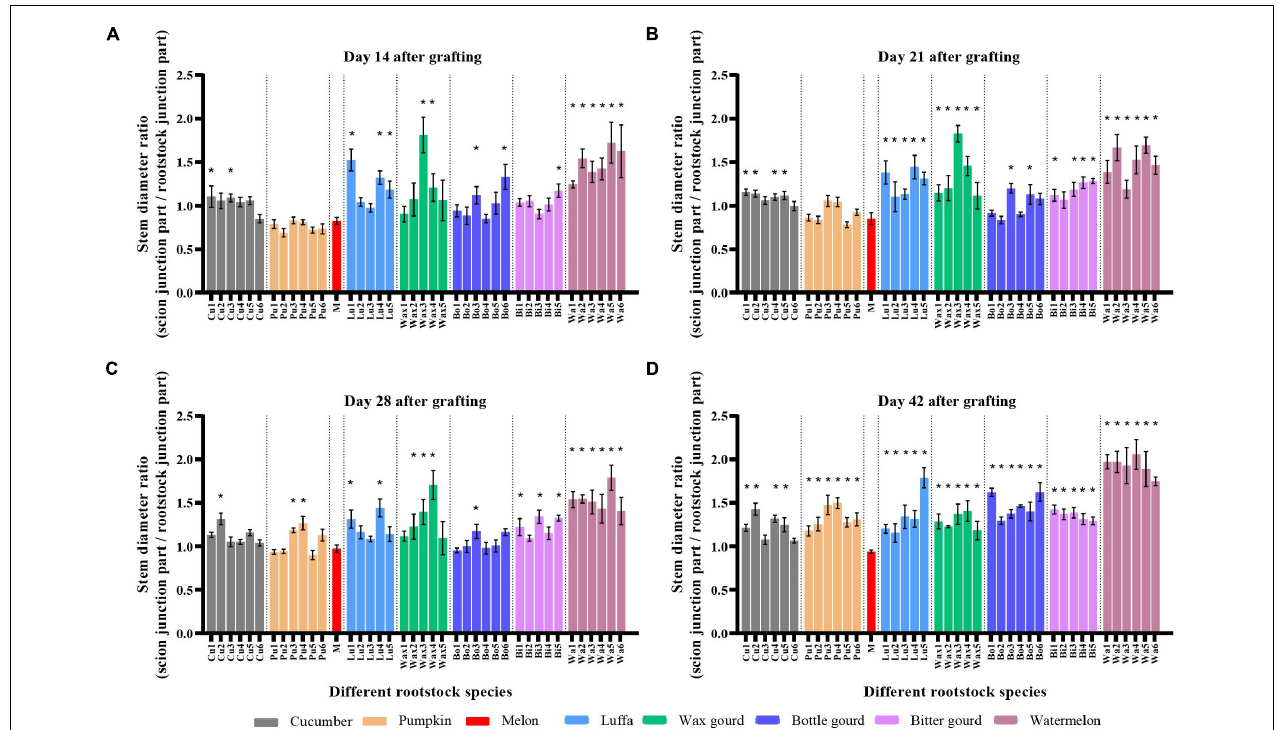
FIGURE 3 | The stem diameter ratio of scion and rootstock of melon grafted onto eight Cucurbitaceae rootstocks. The stem diameter ratio of scion and rootstock (above and below 5 mm of the graft junction) of melon cv. ‘Akekekouqi’ grafted onto cucumber (Cu1–Cu6), pumpkin (Pu1–Pu6), melon (M), luffa (Lu1–Lu5), wax gourd (Wax1–Wax5), bottle gourd (Bo1–Bo6), bitter gourd (Bi1–Bi5), and watermelon (Wa1–Wa6) on day 14 (A) , day 21 (B) , day 28 (C) , and day 42 (D) after grafting. Asterisks indicate a significant difference between melon homo-grafted plants and hetero-grated plants using the Student’s t -test ( p <